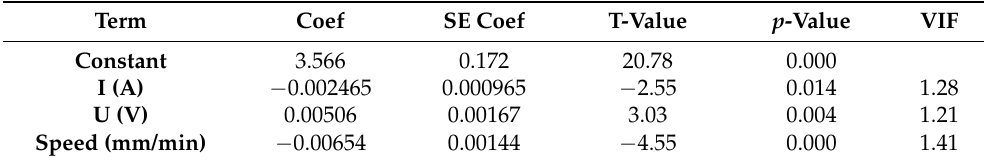
Table 3. ANOVA analysis of parameter’s effect on bead height.